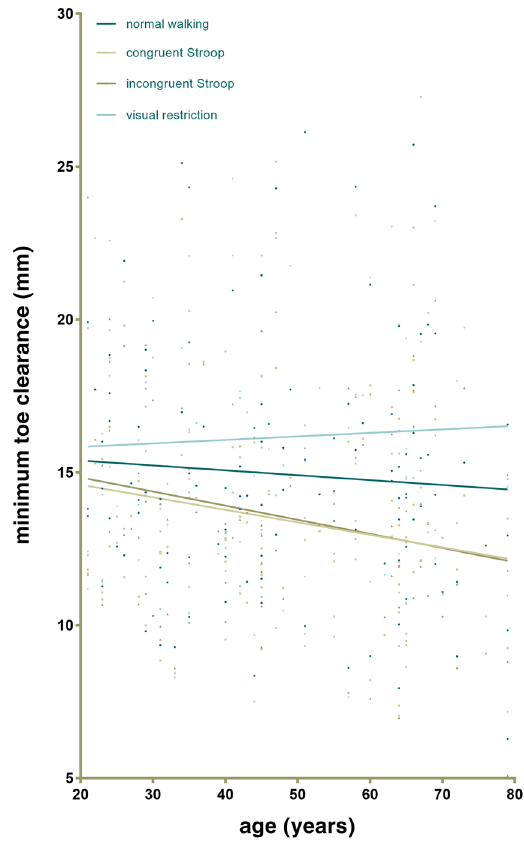
Figure 3. Scatter plot of age and mean minimum toe clearance under four walking conditions. During the congruent and incongruent Stroop tasks, age was a significant, but weak, negative predictor of MTC, with R 2 values of 0.043 (F = 4.9; p = 0.030) in the congruent and 0.050 (F = 6.0; p = 0.016) in the incongruent task. During normal walking and visual restriction, no such relationship was